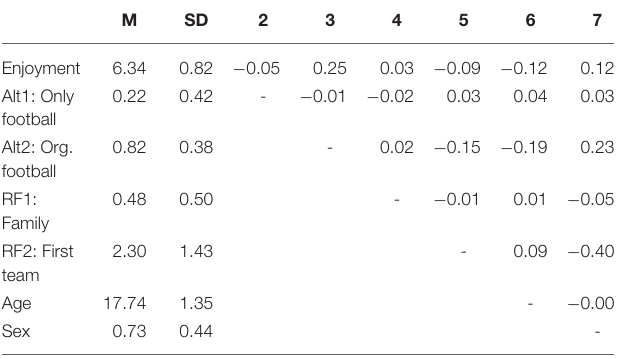
TABLE 1 | Means, standard deviations, and correlations ( n =